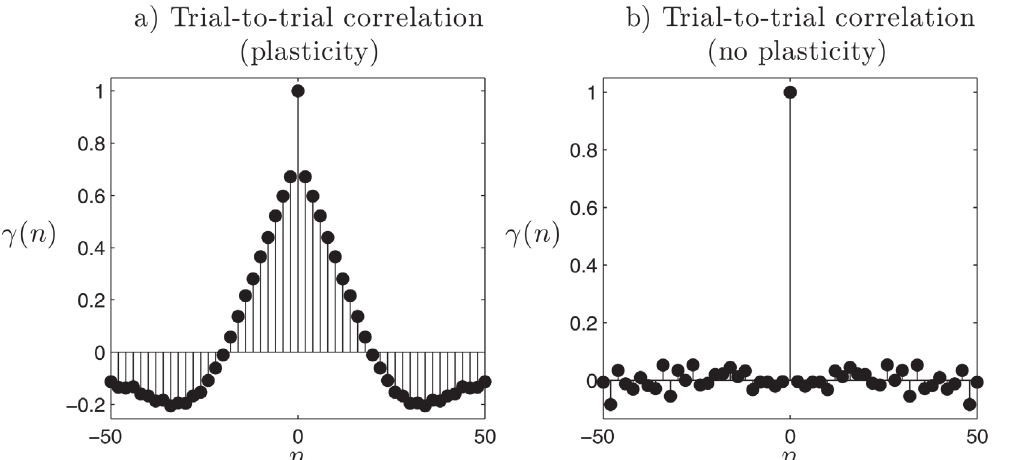
Fig 4. Cross-correlation between the agent ’ s decisions. We compute the cross-correlation between the time series of the decisions made by the agent at the end of each trial (where 1 means light A and − 1 light B ). We observe how consistent trial-to-trial cross-correlations only arise for the agent with synaptic